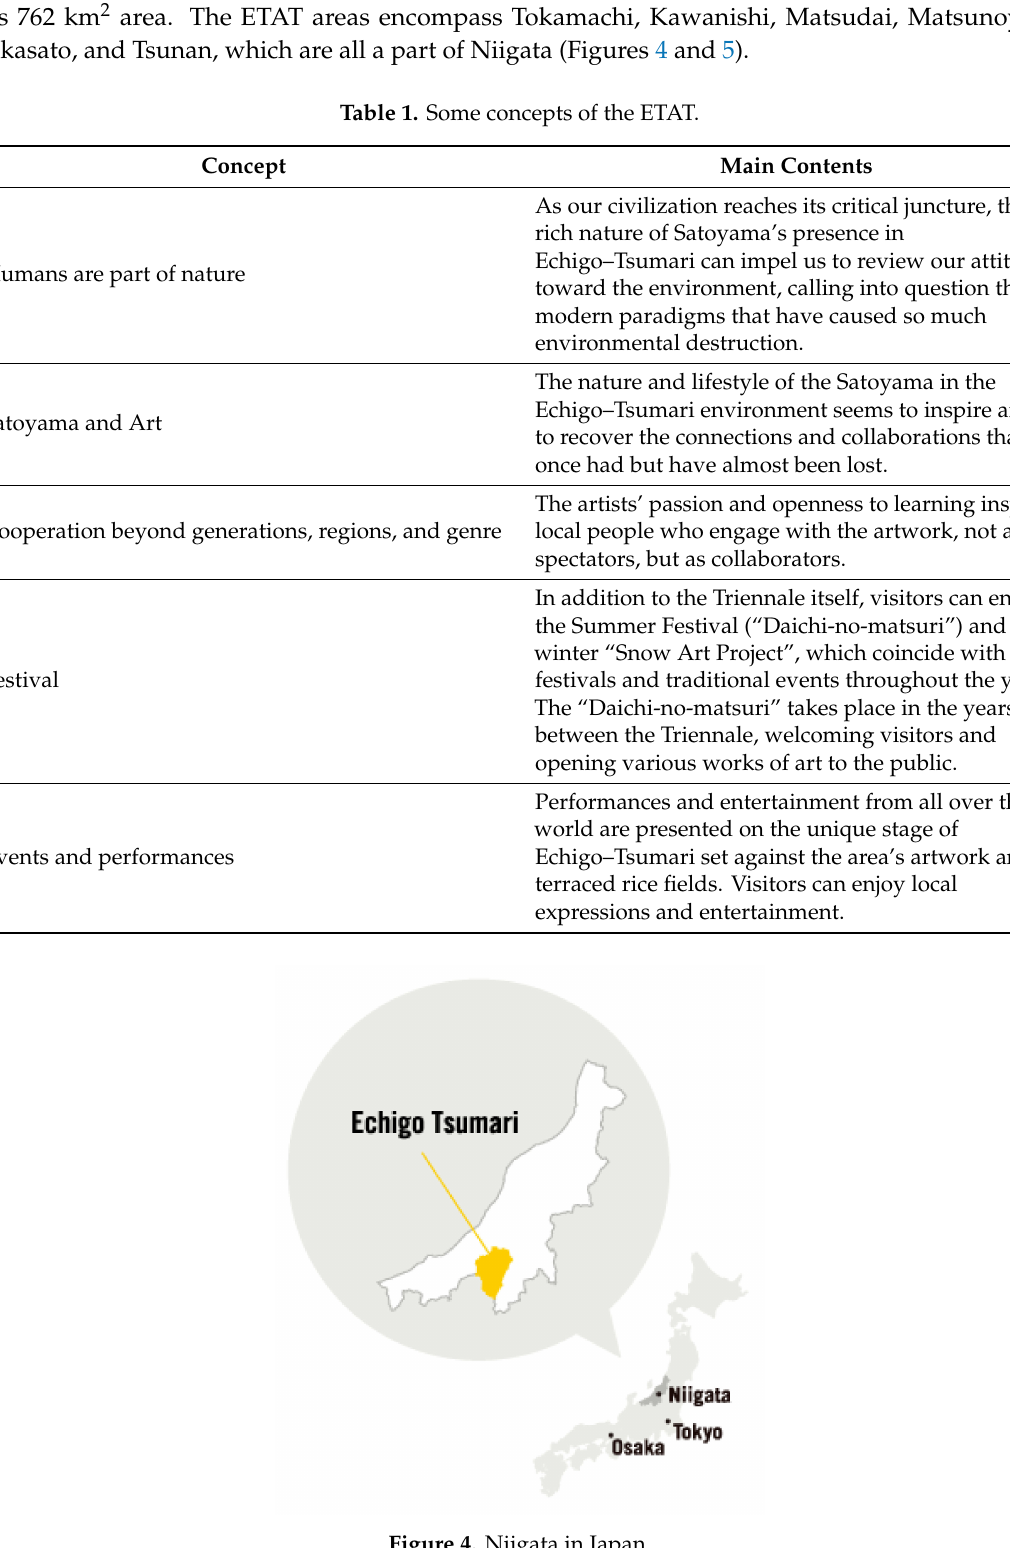
Figure 4. Niigata in